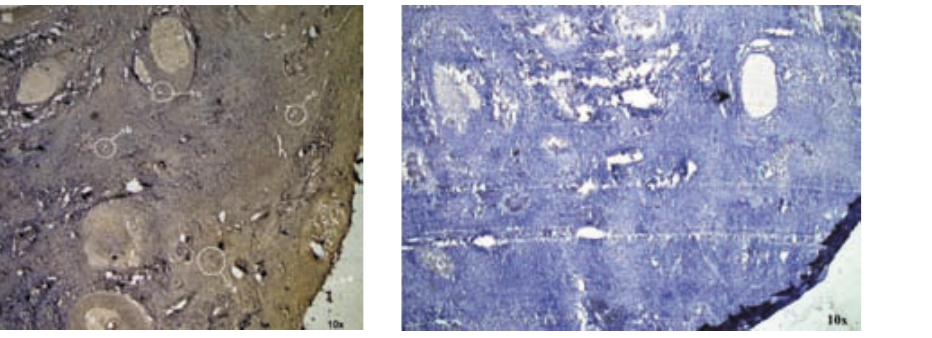
Fig.8 Negative control of Fig.7 Fig.7 Ang-2 expression during follicular development: